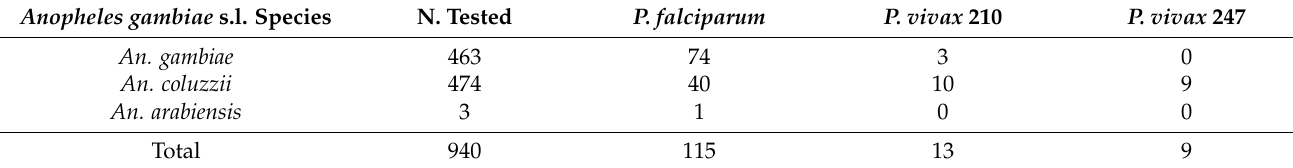
Table 4. Distribution of Plasmodium species in the sibling species of An. gambiae